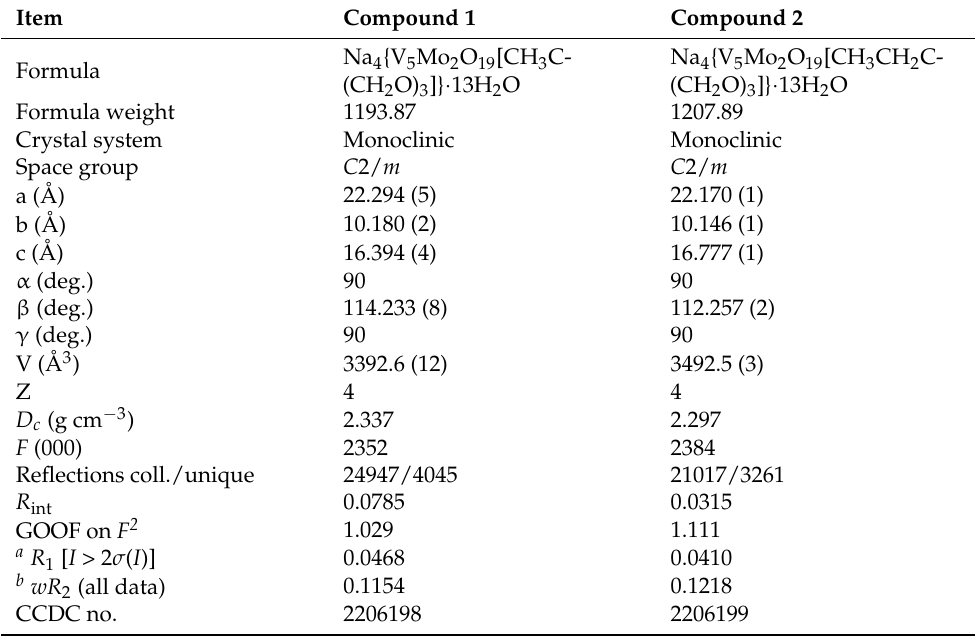
Table 2. The summary of crystal data and structural refinements for compounds 1 and 2